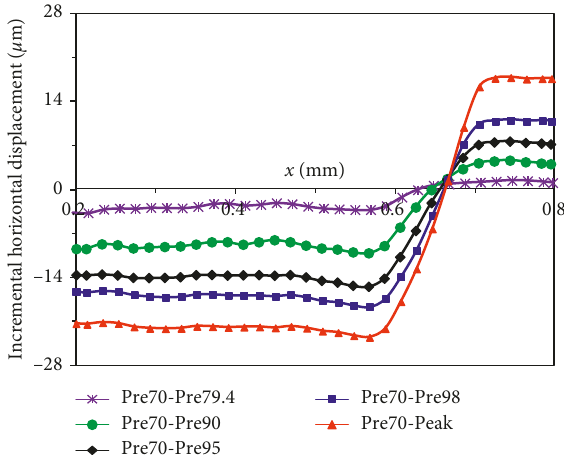
Figure 10: Variation in total horizontal incremental displacement for specimen TPB-0.6-1 along the line y different loading